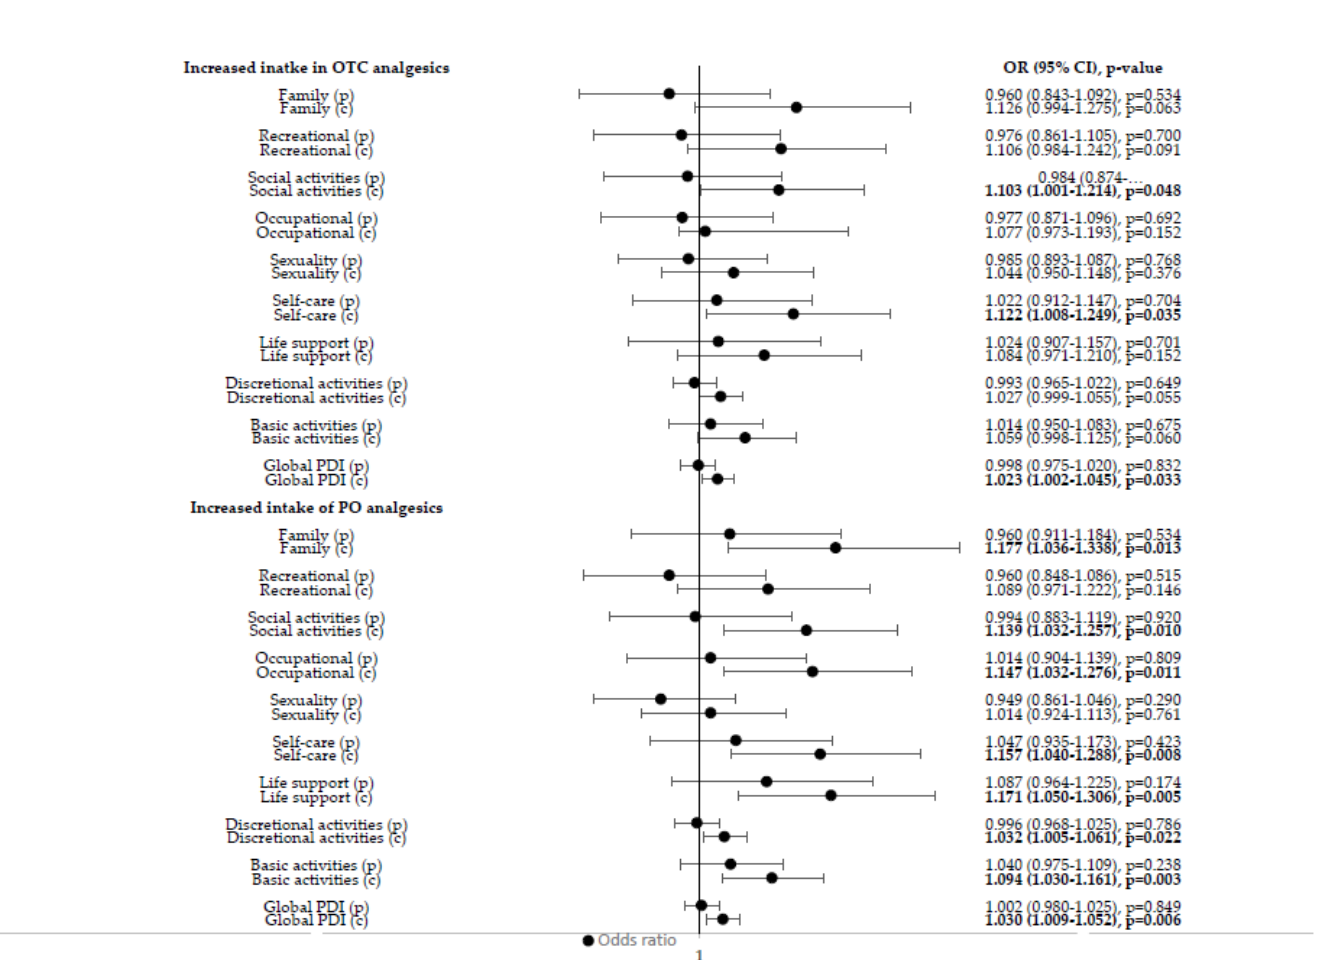
Figure 3. Influence of pain-induced disability of daily life activities on increased intake of OTC and PO analgesics (univariate logistic regression analysis). OTC = over the counter; PO = prescription only; OR = odds ratio; CI = confidence interval; p = previous to the COVID-19 pandemic; c = current. Values in bold indicate statistical significance, as the level of statistical significance was set to p < 0.05.